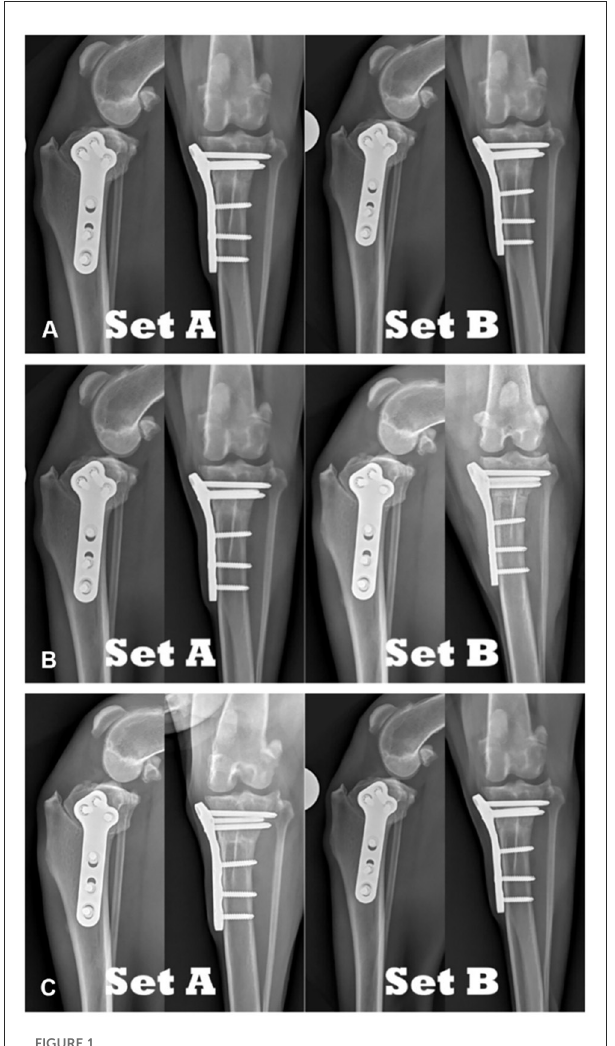
FIGURE1 Comparison of TPLO radiographs of the same patient: (A) 8-weeks postoperative compared to 8-weeks postoperative. (B) 8-weeks postoperative compared to 6-weeks postoperative. (C) 6-weeks postoperative compared to 8-weeks postoperative.